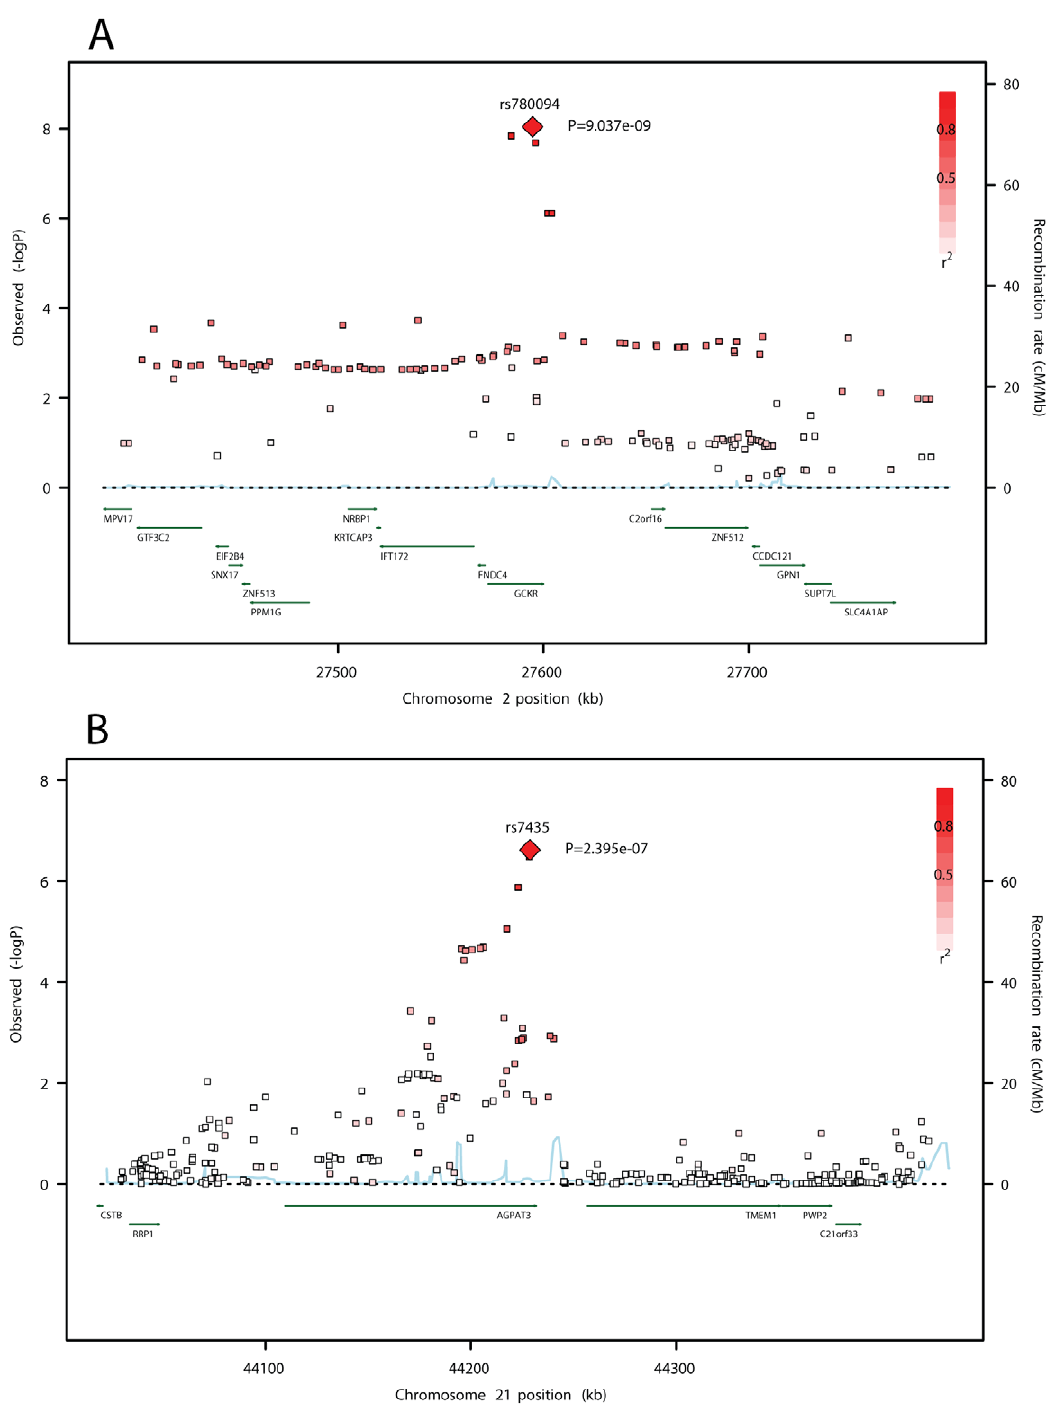
Figure 4. SNP association plots for DPA–associated regions. Genome-wide association significance level is plotted against the y-axis as –log 10 (p-value). Genetic coordinates are as per NCBI build 36. A) GCKR region. LD is indicated by color scale in relationship to marker rs780094. B) AGPAT3 region. LD is indicated by color scale in relationship to marker rs7435. The color scheme is red for strong linkage disequilibrium (LD; r 2 $ 0.8) and fading color for lower